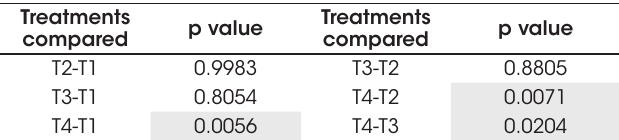
Tukey test – carbonation depth Tukey test- salt